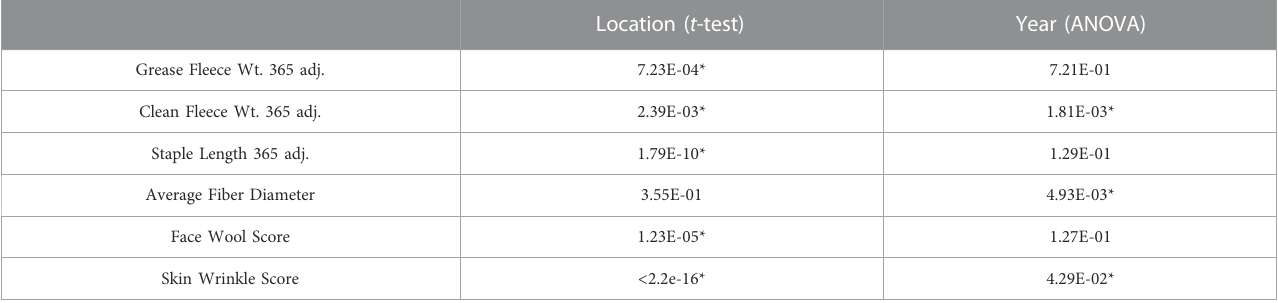
Location ( t -test)